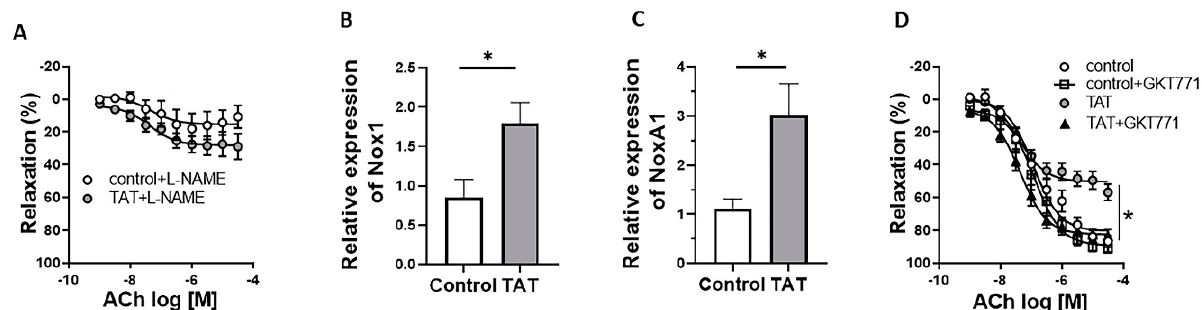
Figure 3. Tat-induced endothelial dysfunction is mediated by Nox1. Concentration response curves (CRC) to acetylcholine (Ach) in aortic rings in the presence of L-NAME (100 µ mol/L) ( A ) or GKT771 (10 µ mol/L) ( D ) and gene expression of Nox1 ( B ) and NoxA1 ( C ) in thoracic aorta from control (vehicle-treated) and TAT-treated mice (TAT, 3.2 µ g/kg per day for 3 days, i.p.). Data are presented as mean ± SEM. n = 5–6; * p < 0.01 vs. Ctrl.